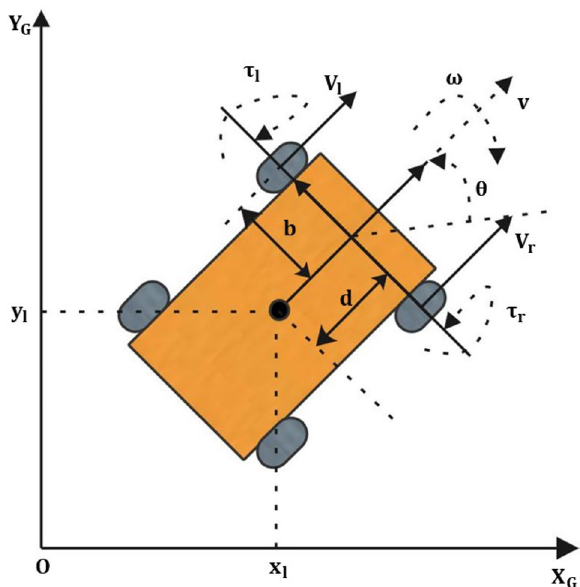
Figure 1. UGV configuration.